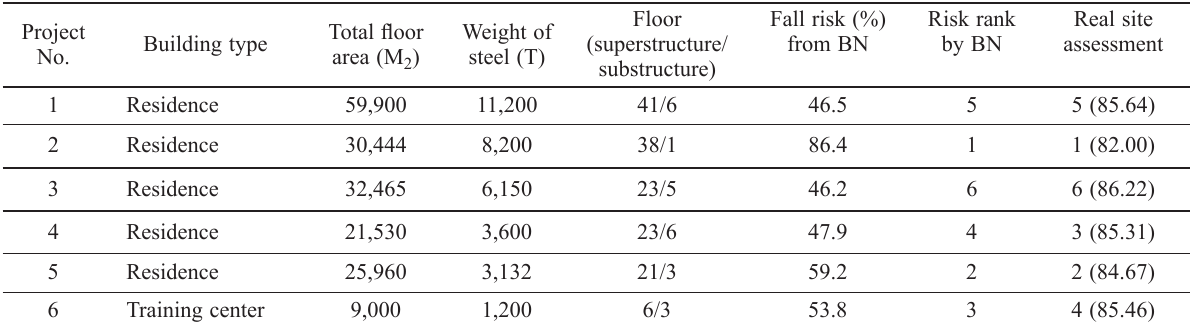
Table 1. Comparison between Bn and real site assessment Project